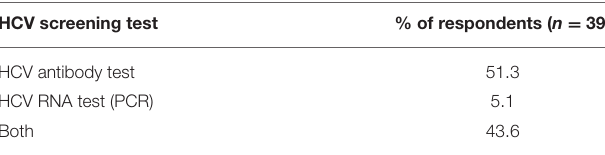
TABLE 4 | Incidence of becoming HCV + during study follow-up, among Chinese HD Patients in DOPPS, by study phase. DOPPS study phase